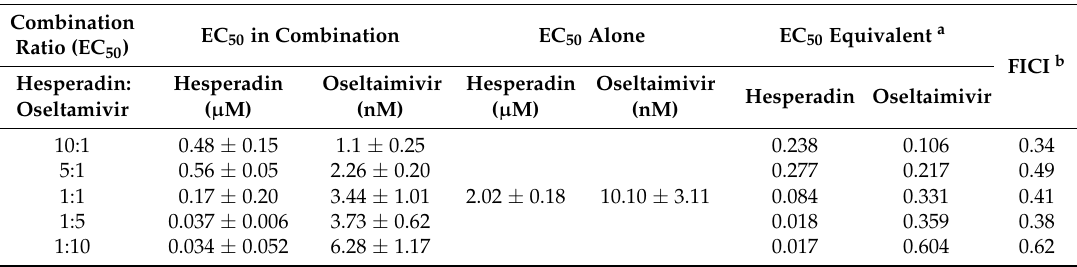
Table 2. Antiviral results of combinational